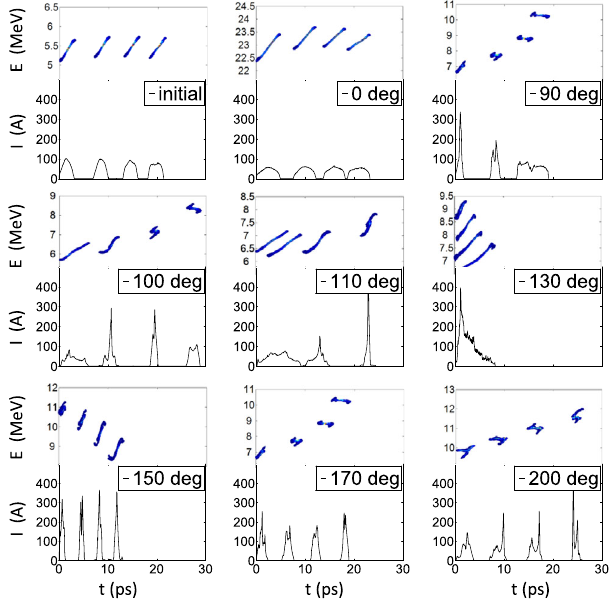
FIG. 11. High-charge four-bunch case: ASTRA simulations of the longitudinal distributions and phase spaces for the compres- sion of a four-bunch train with different injected phases ϕ 0 , where the charge of each subbunch is 200 pC.